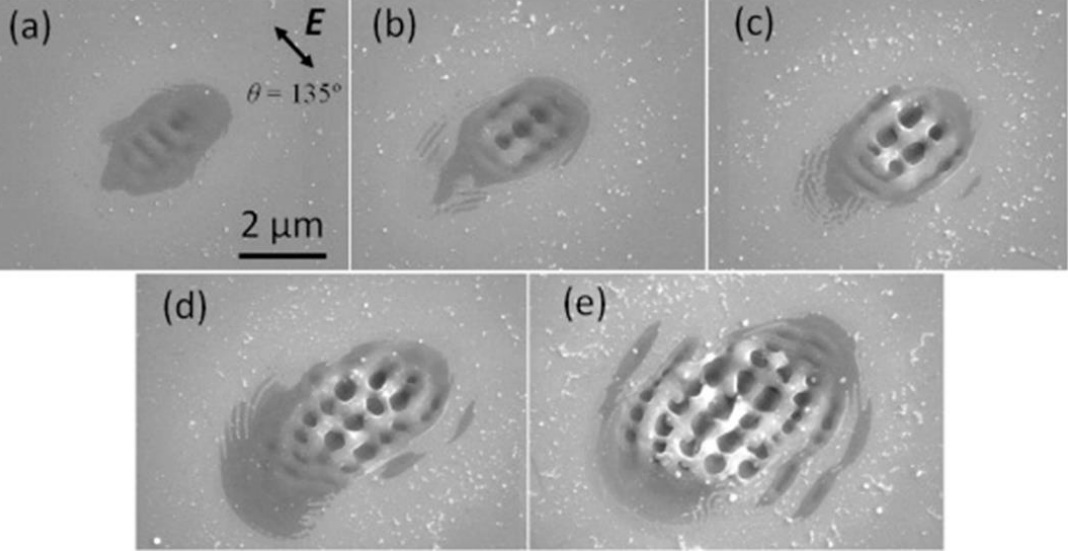
Figure 4. Ref. [58] SEM images of periodic structures induced on the surface of a silicon wafer by femtosecond laser at a fixed laser fluence ( F = 0.22 J/cm 2 ) with different pulse number (N): ( a ) N = 2, ( b ) N = 4, ( c ) N = 6, ( d ) N = 8 and ( e ) N = 10, respectively. The arrow shows the direction of laser polarization.